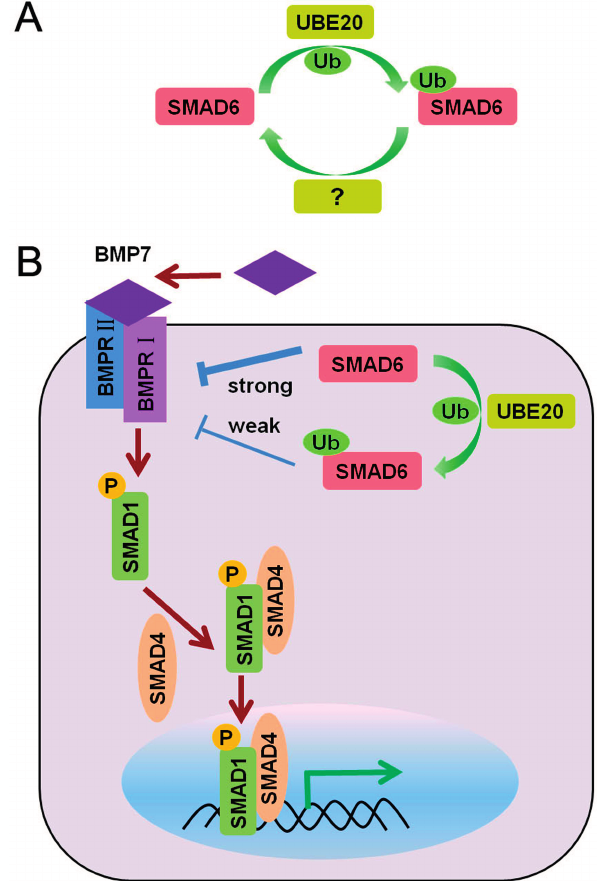
Figure 5. ( A ) Proposed model for regulation of SMAD6 mono-ubiquitination by UBE2O and a hypothetical DUB; ( B ) Mono-ubiquitination of SMAD6 impairs its binding to the BMP type I receptor thereby elevating BMP/SMAD